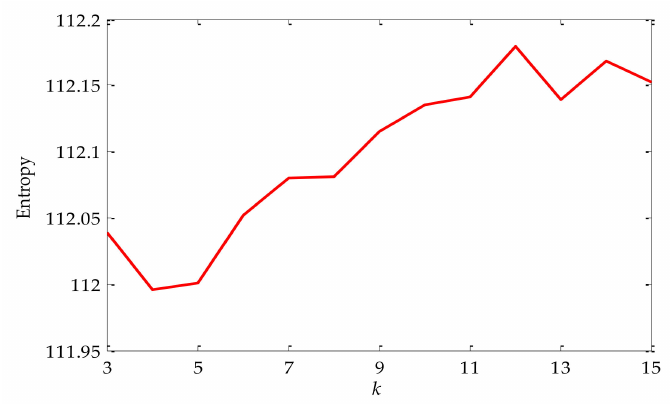
Figure 25. Curve of fitness varying with K